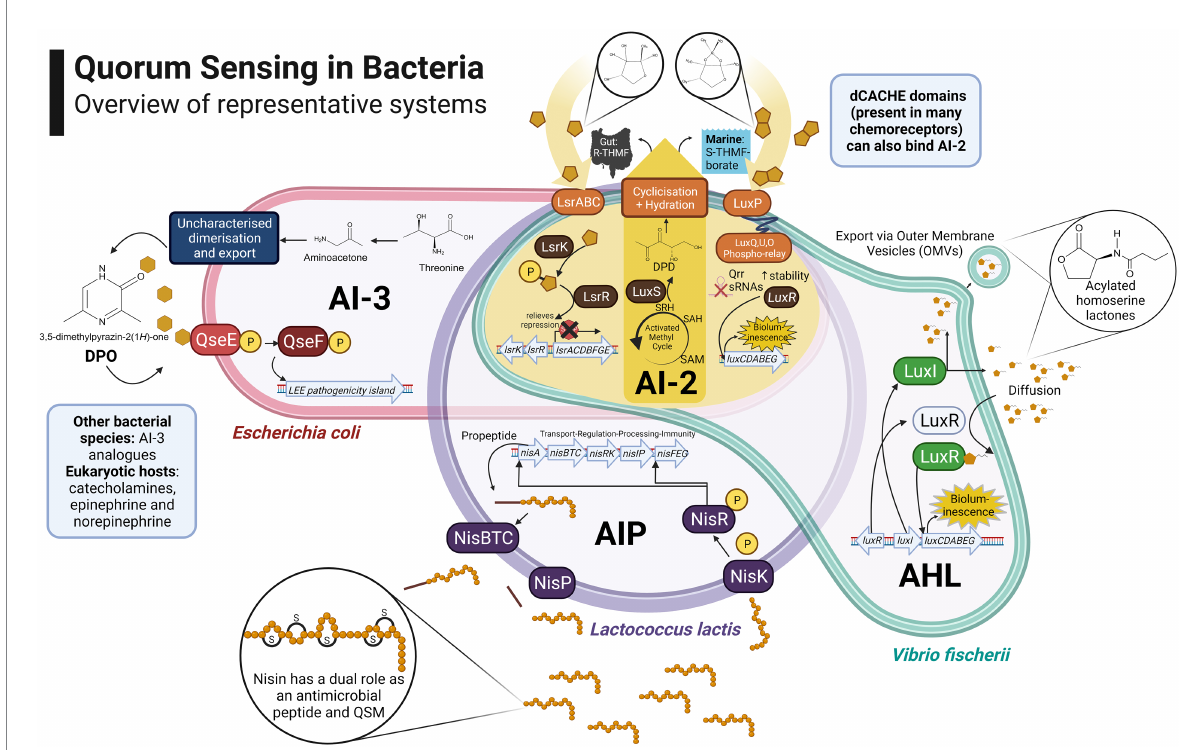
FIGURE 1 Overview of representative bacterial quorum sensing systems: Escherichia coli cell illustrates an Autoinducer 3 (AI-3) Quorum Sensing (QS) system which regulates the locus of enterocyte effacement (LEE) pathogenicity island (Walters and Sperandio, 2006; Machado Ribeiro et al., 2021); an Autoinducing Peptide (AIP) system in Lactococcus lactis is presented, in which nisin has a dual role as a Quorum Sensing Molecule (QSM) and antimicrobial peptide (Kleerebezem, 2004); Vibrio fischeri cell illustrates the control of bioluminescence through an Acylated Homoserine Lactone (AHL) system also referred to as Autoinducer 1 (AI-1; Nealson, Platt and Woodland Hastings, 1970); Autoinducer 2 (AI-2) signalling is presented at the intersection due to its role in species- and genera-agnostic communications. The AI-2 biosynthetic pathway is highlighted in yellow alongside the Lsr/Lux pathways which provide for its internalisation/detection in various genera (Pereira, Thompson and Xavier, 2013). Created with